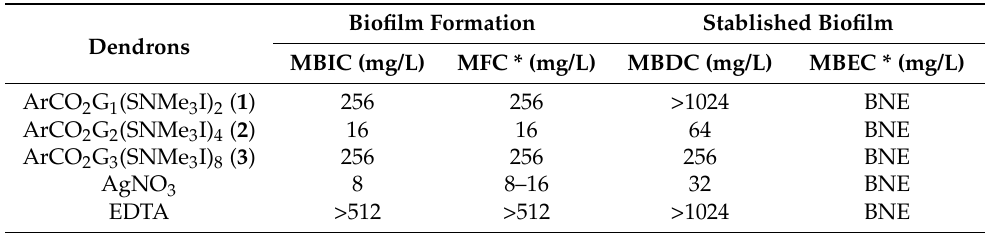
Table 1. Antifungal activity against C. albicans CECT1002 of compounds 1 – 3 in biofilm formation (MBIC and MFC * (mg/L)) and in stablished biofilm (MBDC and MBEC * (mg/L)).